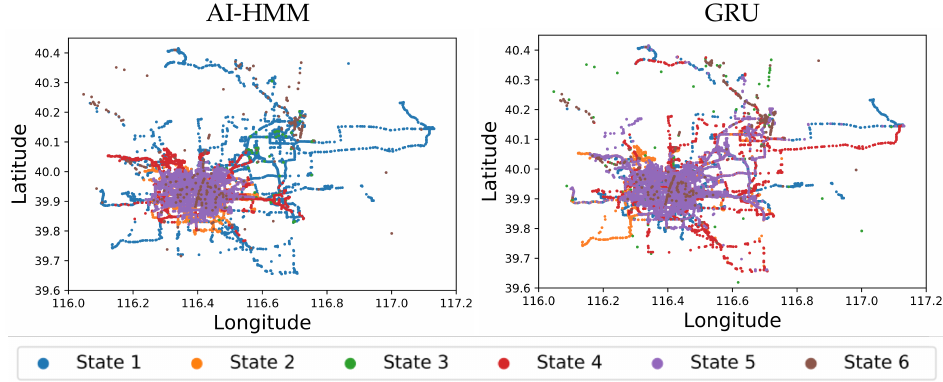
Figure 6. Results obtained from analysing 10 taxi trajectories using the novel AI-HMM framework ( left ) and the GRU technique ( right ). Each data point corresponds to a GPS observation where its colour represents the state to which it was assigned. The plots depict the longitude λ against latitude l reconstructions of the movements of the taxi locations on a